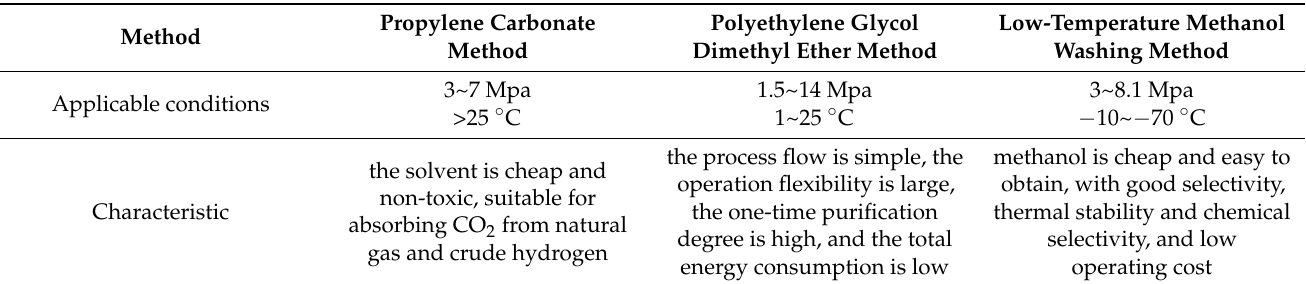
Table 2. Comparison of physical absorption